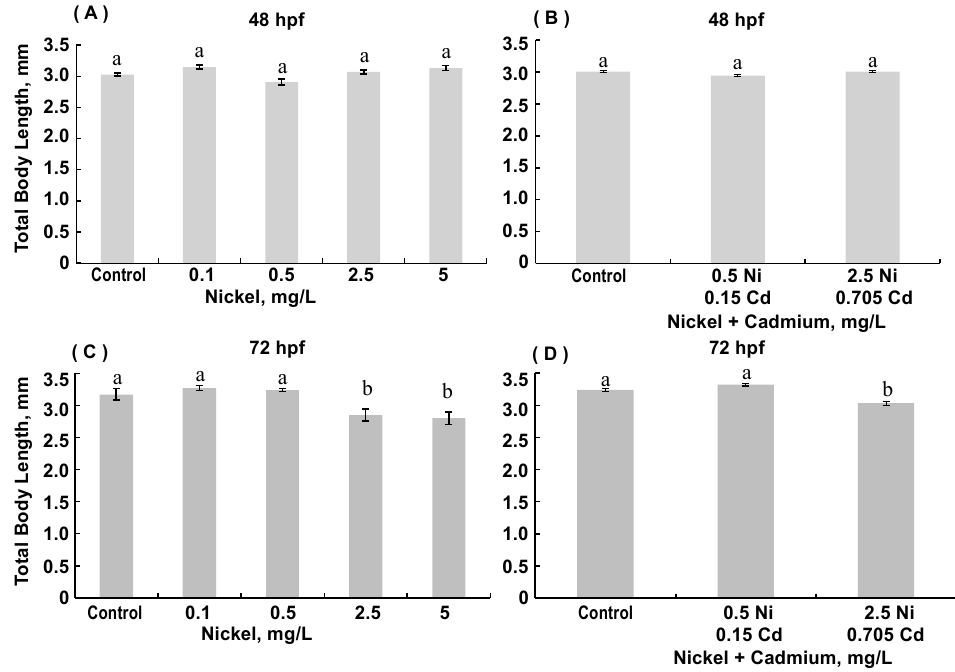
Figure 2. Total body length in 48 hpf ( A , B ) and 72 hpf ( C , D ) zebrafish embryos reared in medium containing 0.1–5 mg/L Ni and combinations of either 0.5 mg/L Ni + 0.15 Cd or 2.5 mg/L Ni + 0.705 mg/L Cd. ( A ): 48 hpf with Ni exposure, ANOVA p < 0.0001. ( B ): 48 hpf with exposure to combinations of Ni and Cd, ANOVA p = 0.0107. ( C ): 72 hpf with Ni exposure, ANOVA p < 0.0001. ( D ): 72 hpf with combined exposure to Ni and Cd, ANOVA p < 0.0001. (Data are means ± SEM for N = 50–80 surviving embryos.)